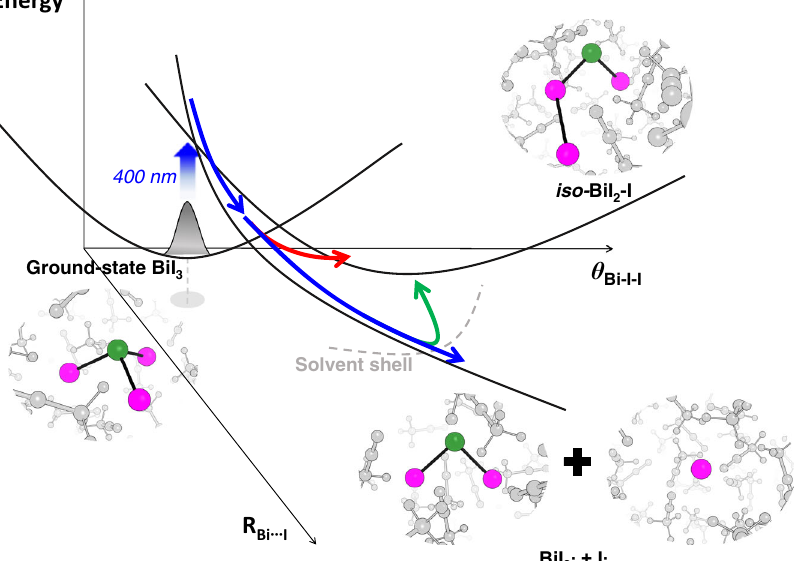
Fig. 1 A schematic representation for the photodynamics of BiI 3 in acetonitrile. Upon 400 nm excitation, BiI 3 in acetonitrile solution undergoes isomerization to form iso -BiI 2 -I and dissociation to form BiI 2 • and I • radicals. The kinetics and structural movements at the initial stage of those reactions were investigated in this study. Here, we answer the following three questions using fs-TRXL; (i) roaming-mediated direct isomerization or cage-induced isomerization, (ii) wavepacket trajectory for the isomerization, and (iii) wavepacket trajectory of the dissociation fragments. Qualitative potential energy surfaces are shown along the Bi···I distance (R Bi···I ) and Bi-I-I angle ( θ Bi-I-I ). Green and magenta spheres represent the Bi and I atoms, respectively. The solvent cage surrounding the solute molecules is represented by gray spheres. Possible wavepacket trajectories are represented with colored arrows. The blue, red, and green arrows represent the wavepacket trajectories for the dissociation, roaming-mediated direct isomerization, and cage-induced isomerization.